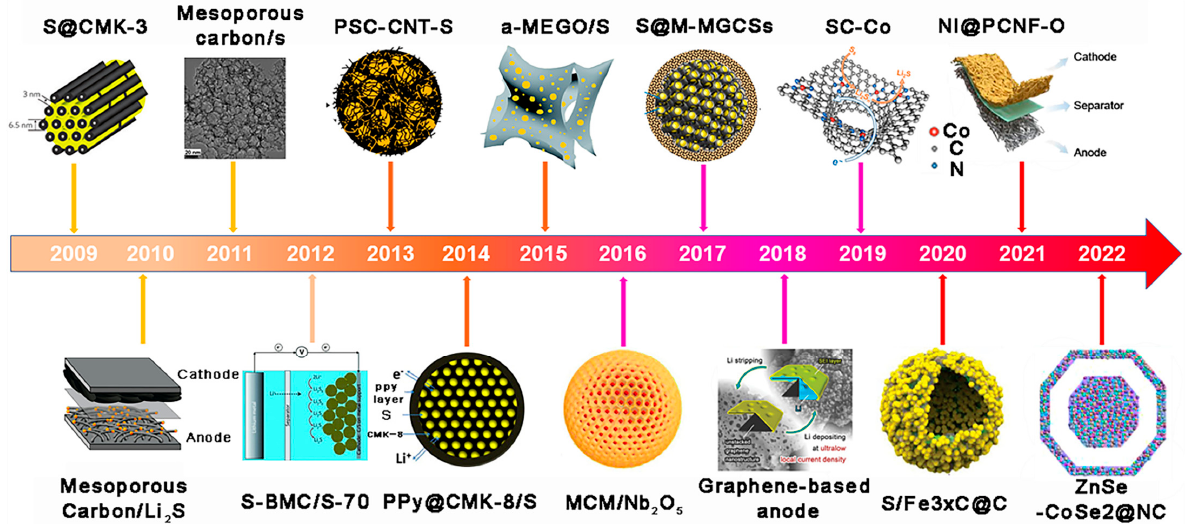
Figure 2. An overview of the history of MCBM and several representative methods for enhancing LSB performance. The representative works inserted in chronological order: S was kept within CMK-3. Over the past ten years, LSBs had had a revival of interest as a result of this e ff ort [35]. Li 2 S was encased within MCBM on the cathode of a Li 2 S/Si ba tt ery [36]. Mesoporous carbon with adjust- able pore diameters [37]. Bulk bimodal mesoporous carbon (BMC-1) as Li-S cathode [38]. Porous